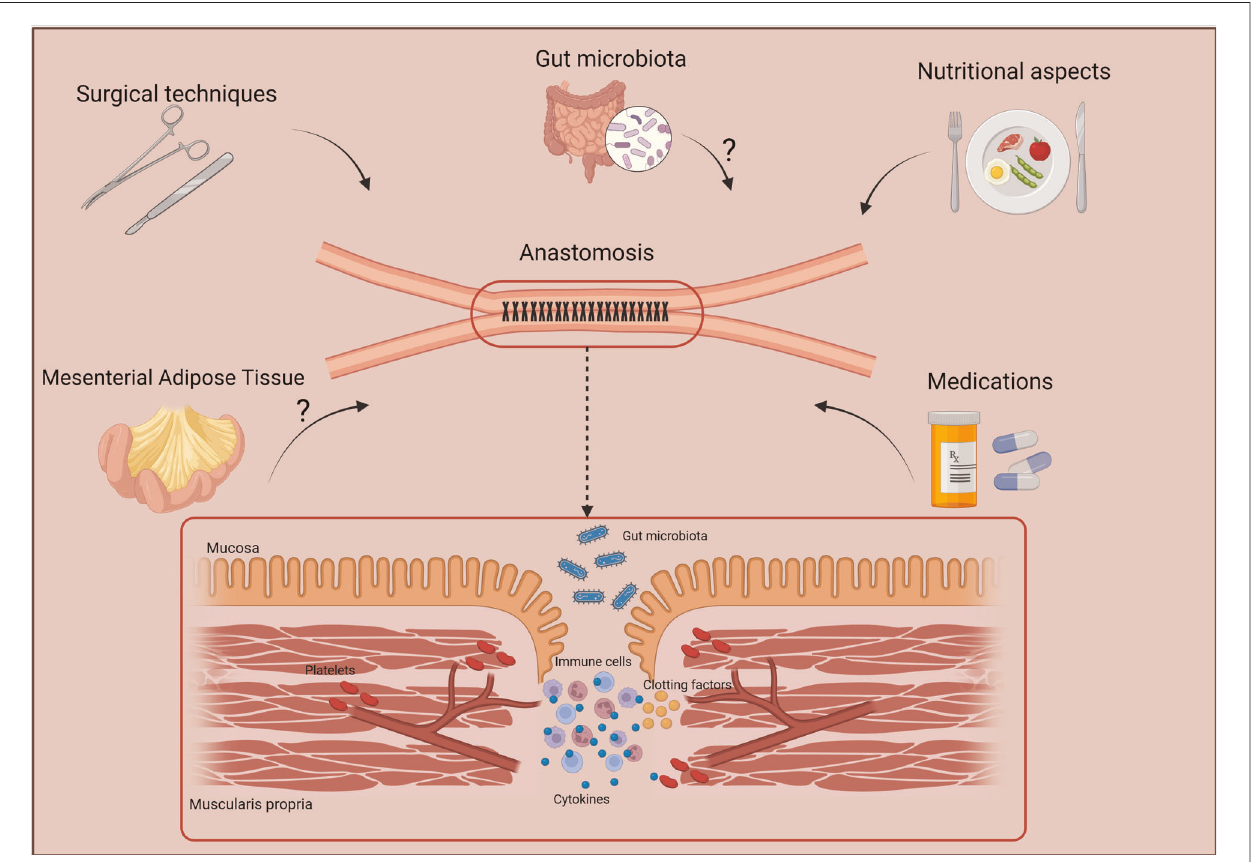
FIGURE 3 | Factors that may in fl uence the effective healing of anastomosis. Several factors may act directly on the correct healing of anastomoses, such as nutritional factors, intestinal microbiota, medications, and the tissues nearby the intestinal affected area such as the mesenteric adipose tissue. Created with